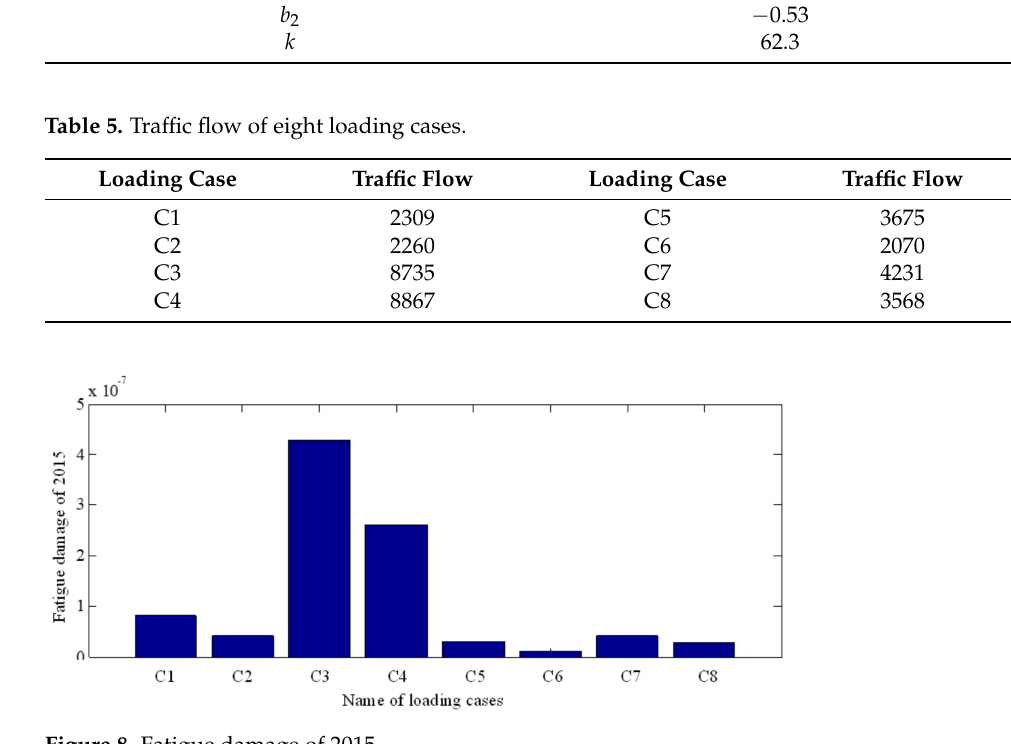
Figure 8. Fatigue damage of